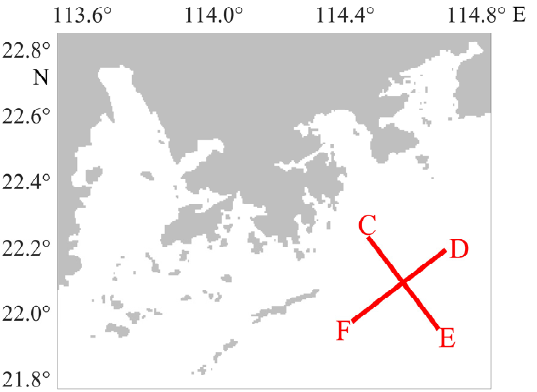
Figure 9. Four directions (D–F, E–C, F–D, and C–E) of constant wind fields used to drive the nested-grid modeling system. Table 2. Directions and speeds of constant surface winds used in driving the nested-grid modeling system in each idealized experiment.